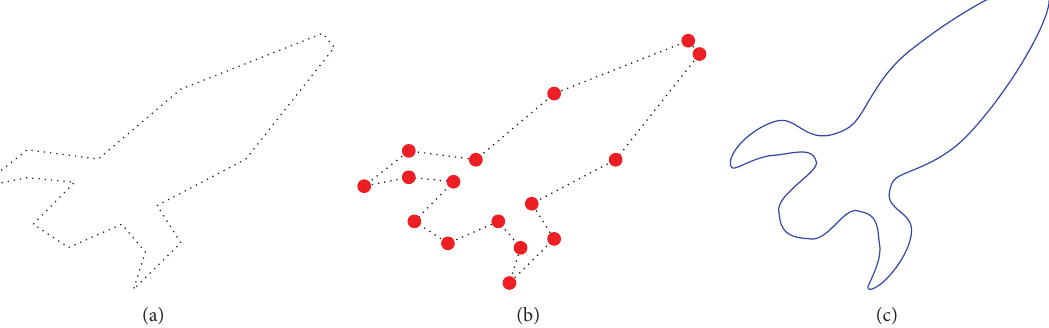
Figure 3: Rational cubic spline interpolant: (a) shape of an image of rocket; (b) depicted data points on the image of rocket; (c) default rational cubic spline curve on the depicted points of the image of